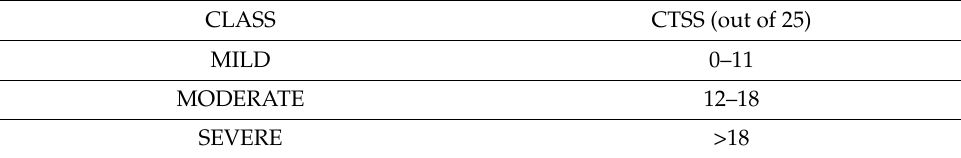
Table 1. Tabular representation of grading of COVID-19 patients based on